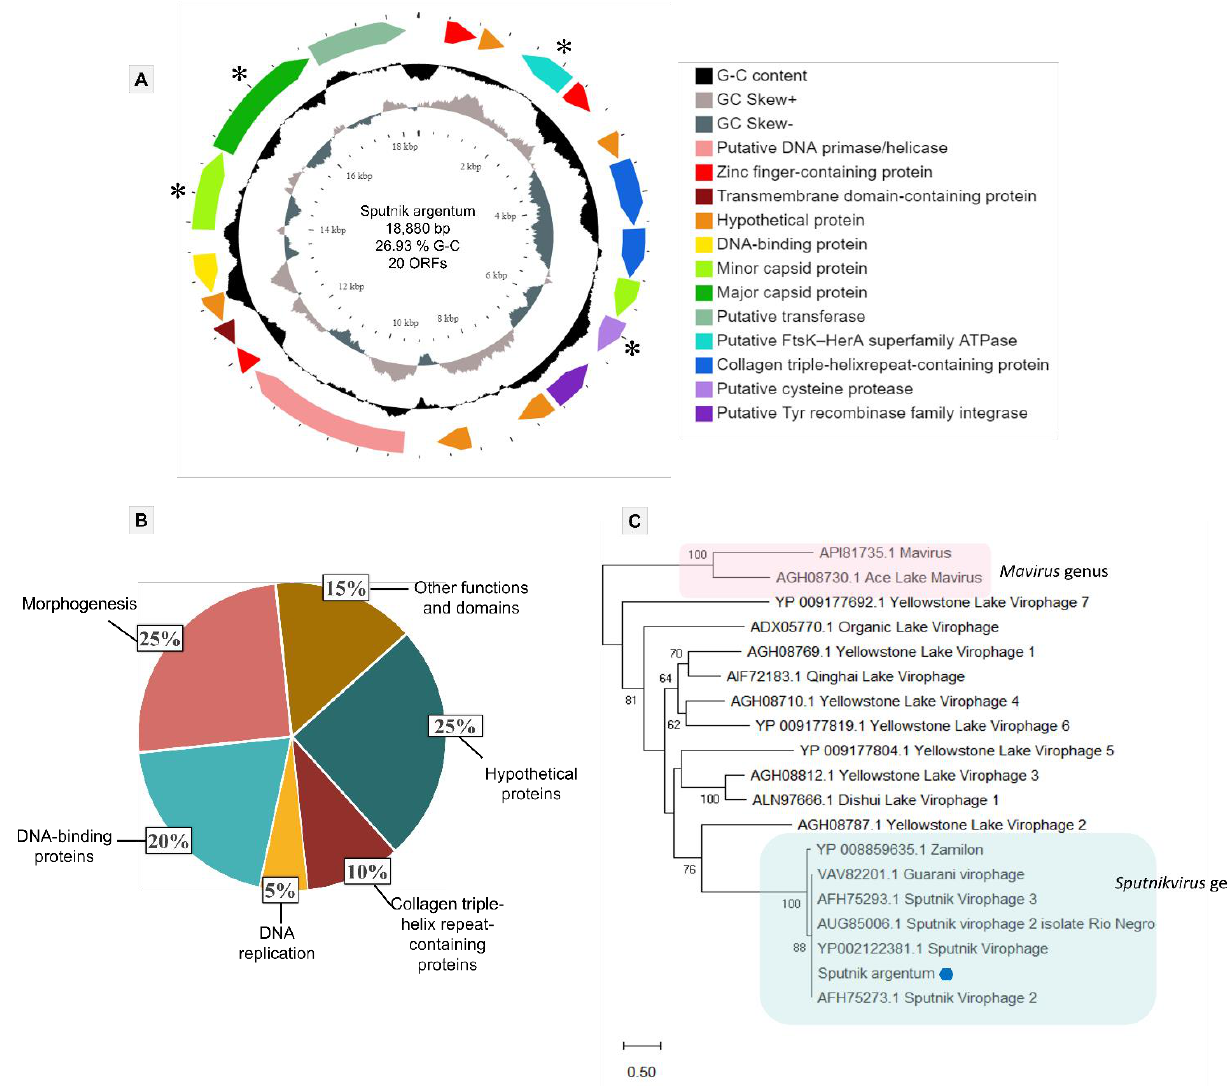
Figure 3. Genome characterization and phylogeny of sputnik argentum. ( A ) Genome representative map of sputnik argentum, showing the G-C content, G-C skew, and the distribution of 20 annotated ORFs throughout the sequence. Predicted function and/or domains are indicated by different arrow colors as described in the color legend. Right-directed arrows represent positive strand ORFs, and left-directed arrows represent negative strand ORFs. Asterisks indicate the core proteins of the Lavidaviridae family. ( B ) Pie chart highlighting the proportion of different protein functions and/or domains and repeats in the sputnik argentum genome. ( C ) Lavidaviridae family maximum-likelihood tree based on the major capsid protein (MCP) amino acid sequence encoded by sputnik argentum (ORF19). The sputnik argentum sequence is indicated by a blue hexagon. The best fit model chosen with ModelFinder (implemented in IQtree) for this tree was rtREV + F + I + G4. The tree scale bar represents the number of amino acid substitutions per site.